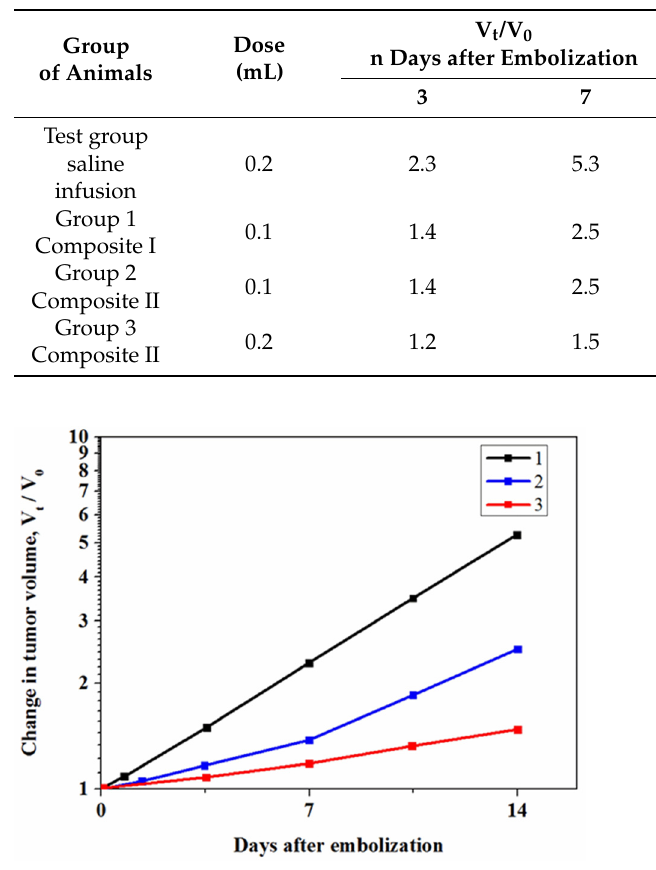
Table 5. The effect of embolization by silicone-based magnetic composites on the dynamics of PC1 tumor growth in rats.